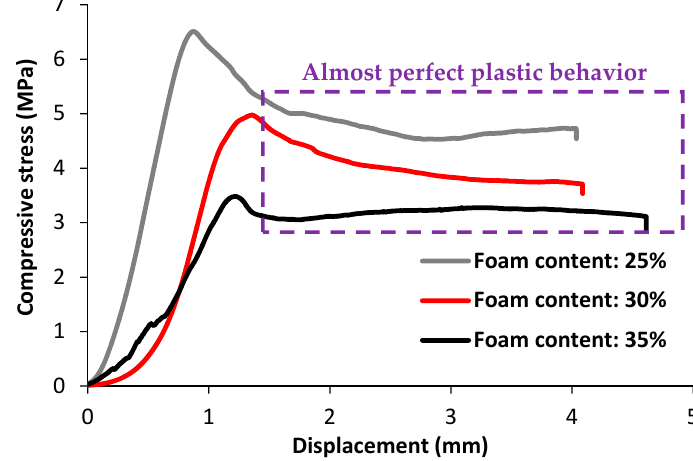
Figure A2. Compressive stress versus displacement curves of the developed lightweight AAM with different foam contents.